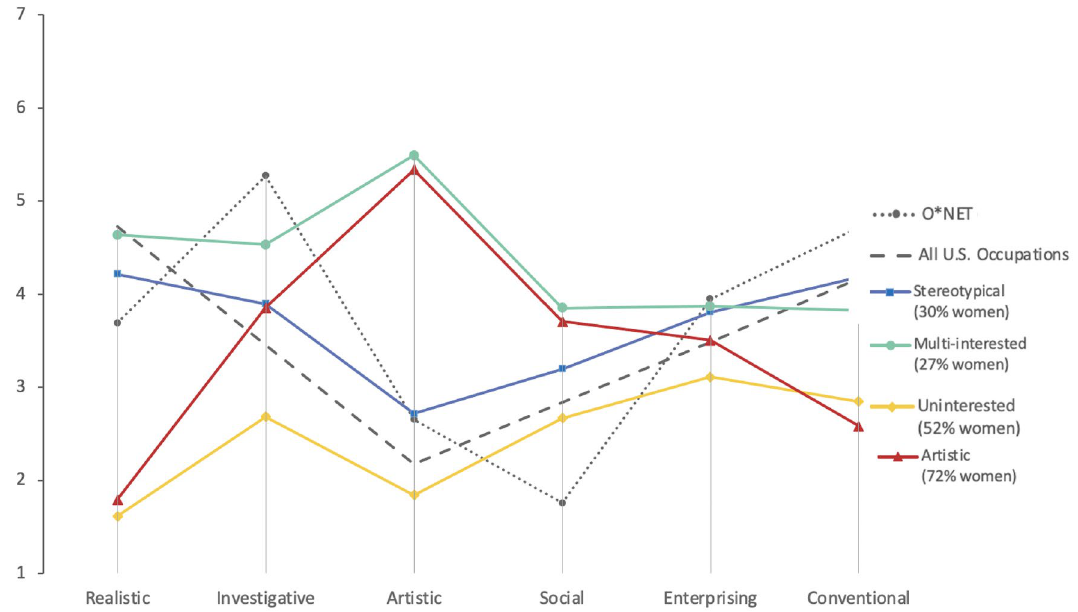
Figure 1. Interest Profiles of Those Employed in CS Compared to O*NET Estimations of CS Interests. Interests were assessed in both the online career interest survey and O*NET according to a scale from 1 to 7, with 7 indicating a stronger preference for/a greater relevance of that interest to the